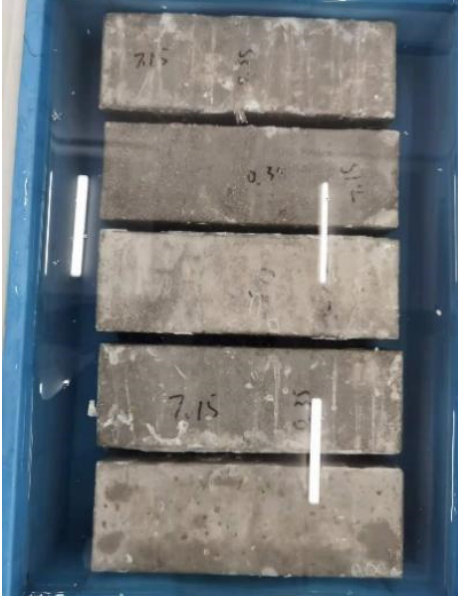
Figure 3. No load, seawater erosion specimen.